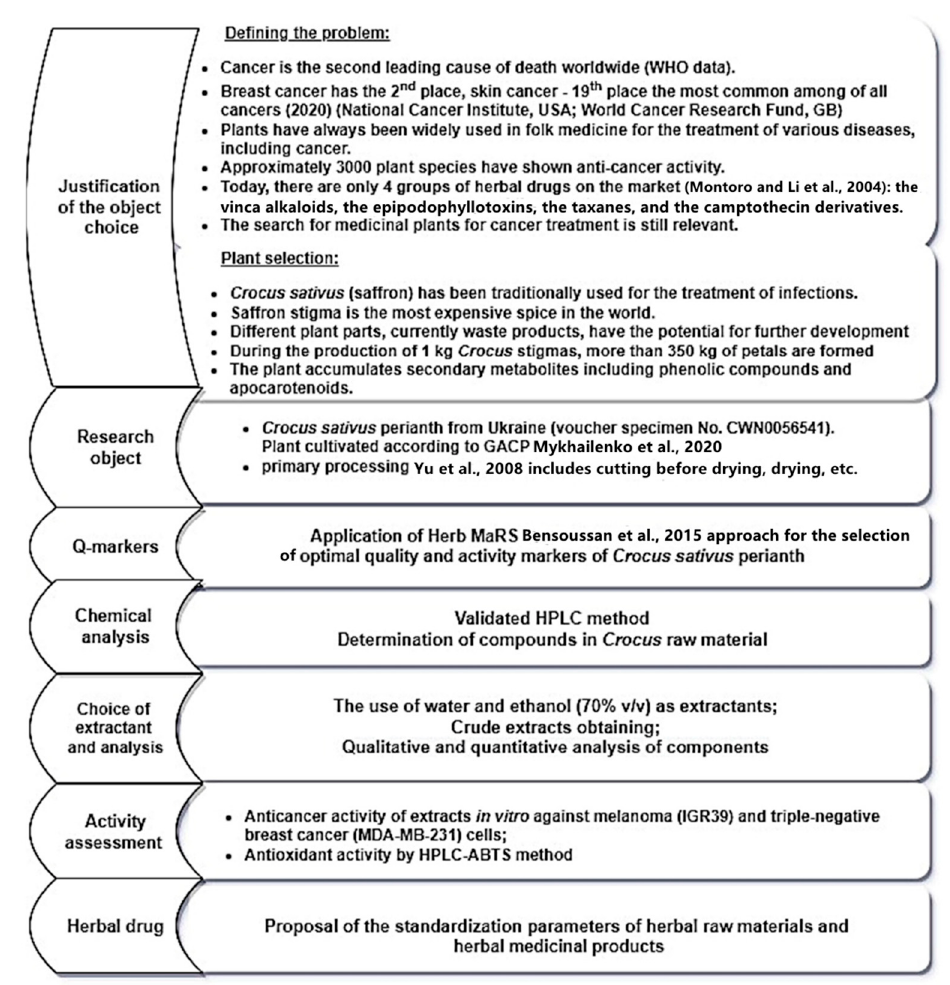
Figure 3. DoE of obtaining C. sativus crude extracts with potential anticancer activity